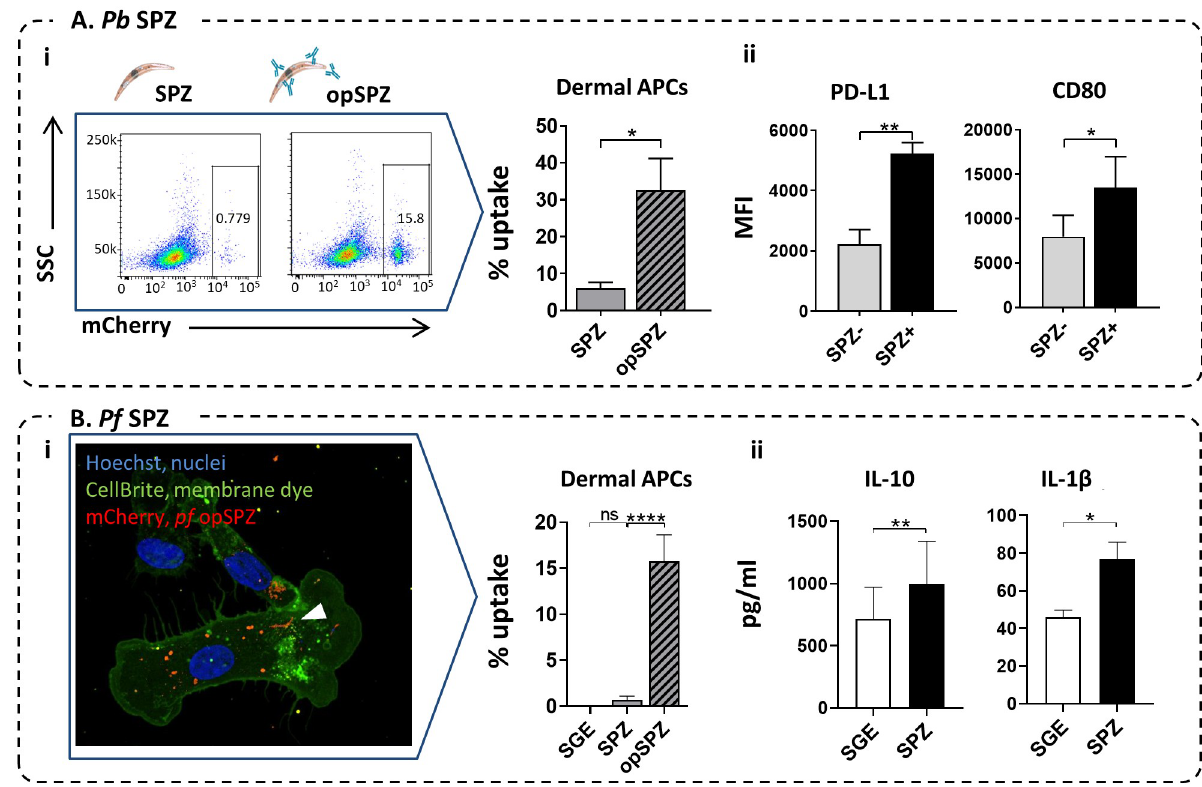
Fig 8. Human skin APC responses to SPZ. A. i . Pb SPZ uptake in dermal APCs (HLA-DR + , CD11c + ) from lysed skin explants. Representative plots and quantification of flow cytometric results. N = 4, 6 donors. Ii . PD-L1 and CD80 expression in lysed dermal APCs in the SPZ + (after uptake of Pb opSPZ) or SPZ - subset. N = 3, 3 donors. B. i . Pf SPZ uptake in dermal APCs (emigrated from human skin explants) Representative image and quantification of confocal microscopy results. N = 3, 3 donors. ii . IL-10 and IL-1 β production by Pf SPZ or SGE stimulated lysed skin cells. � : p = < 0.05, �� : p = < 0.01, ���� : p = < 0.0001. N = 3, 4